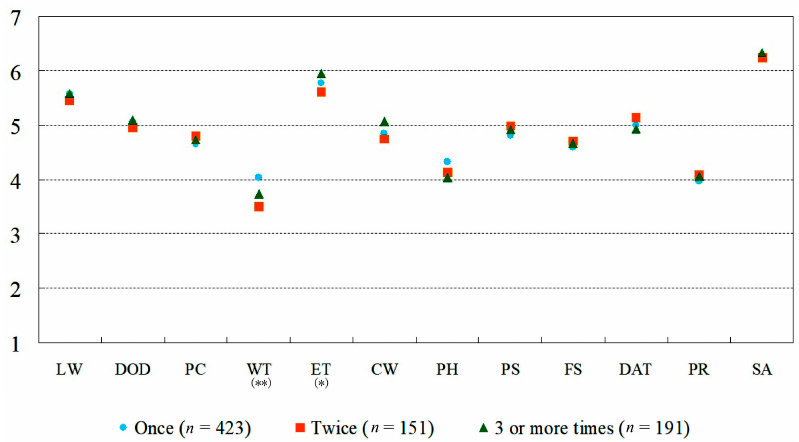
Figure 6. Choice preferences based on number of visits. LW: Landscape the visitor wants to see; DOD: Degree of difficulty; PC: Pavement condition; WT: Watch the forest train; ET: Experience the forest bath; CW: Contact with landscape elements; PH: Photography; PS: Physical strength; FS: Facility status; DAT: Distance and time; PR: Privacy; SA: Satisfaction. ** Significant at the 0.01 level. * Significant at the 0.05 level.